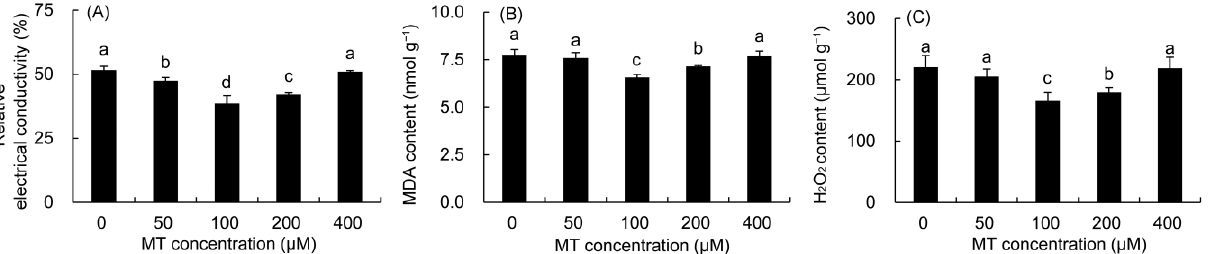
Figure 2. Effects of different concentrations of MT on REC ( A ) and the contents of MDA ( B ) and H 2 O 2 ( C ) in P. vulgaris. MT: melatonin. Data are means ± standard error; different letters indicate significant differences as determined by the Duncan test ( p ≤ 0.05).